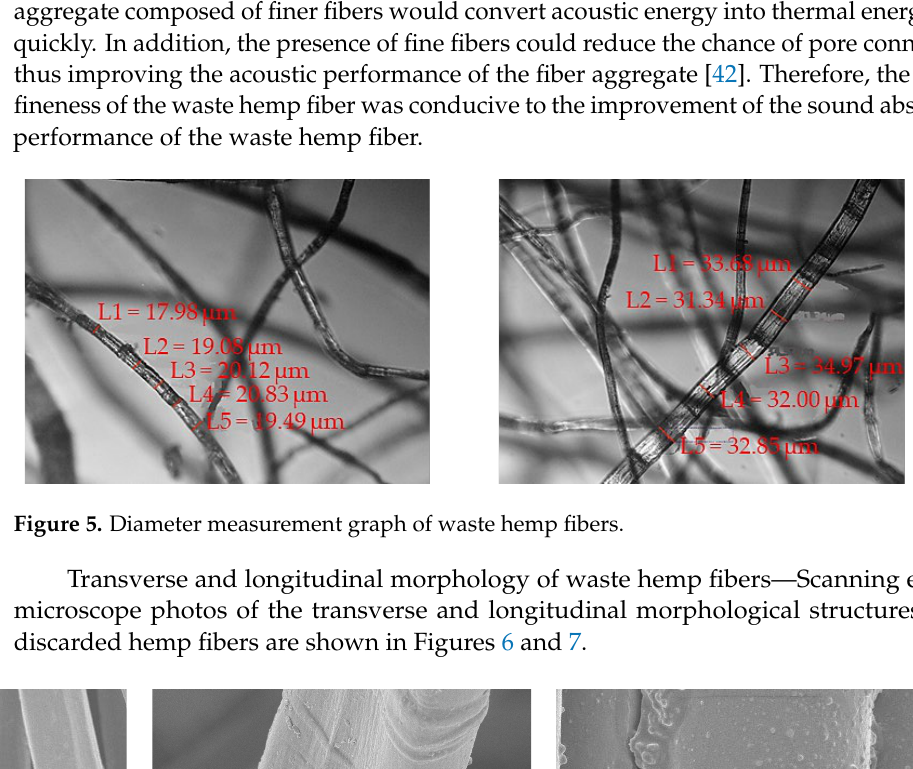
Table 3. Length distribution of waste hemp fibers.